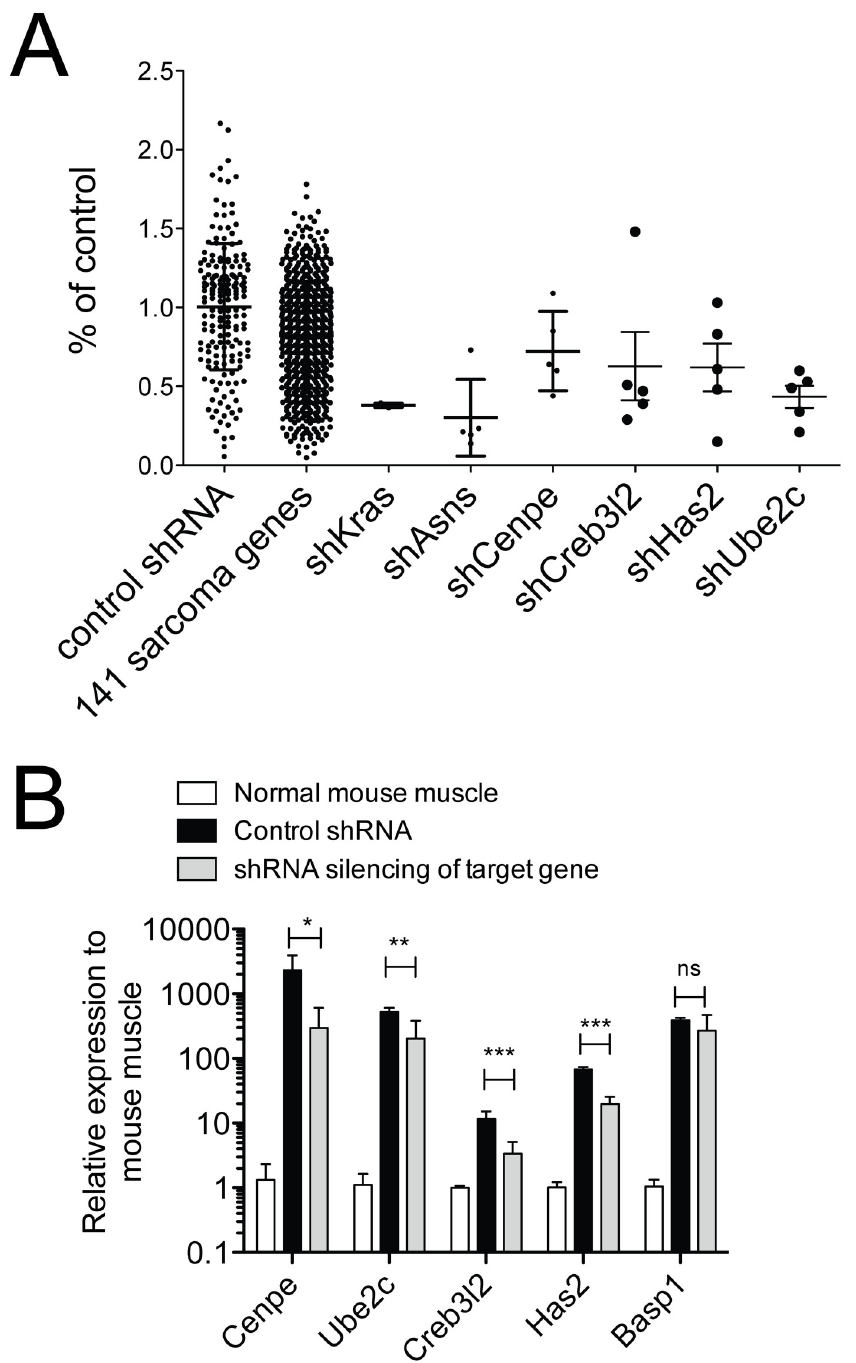
Fig 1. Candidate sarcoma targets. 141 sarcoma-relevant genes were identified by transcriptional profiling of genetically engineered Kras -driven mouse sarcomas [6]. Their contributions to sarcoma growth were probed by customized shRNA screening using 5 shRNAs per candidate gene. Control shRNAs were directed against LUC, RFP and LACZ; shKras served as a positive control [5]. (A) Five candidate genes whose targeting by shRNAs in this screen resulted in reduced sarcoma cell proliferation represent potentially druggable genes/ cellular processes: Asns , Ube2c , Cenpe , Has2 , Creb3l2 . The anti-proliferative effects of the shRNAs directed against these candidate genes in a Kras; CDKN2A null mouse RMS cell line are shown. (B) Effective knockdown by the target-specific shRNAs in Kras; CDKN2A null mouse RMS cells was confirmed by qRT-PCR. Target gene expression was determined by gene-specific qRT-PCR (mean +/- SD of 3 technical replicates presented; ns p � 0.05, � p < 0.05, �� p < 0.01, ��� p < 0.001, as determined by T-tests compared to cntrl-shRNA infected